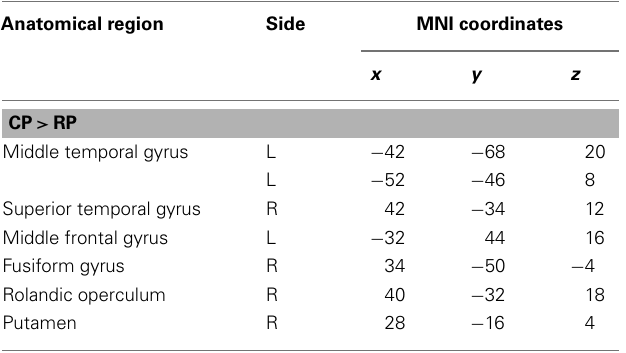
Table 5 | Group activations for the contrast between CP versus RP, p < 0.001, uncorrected.